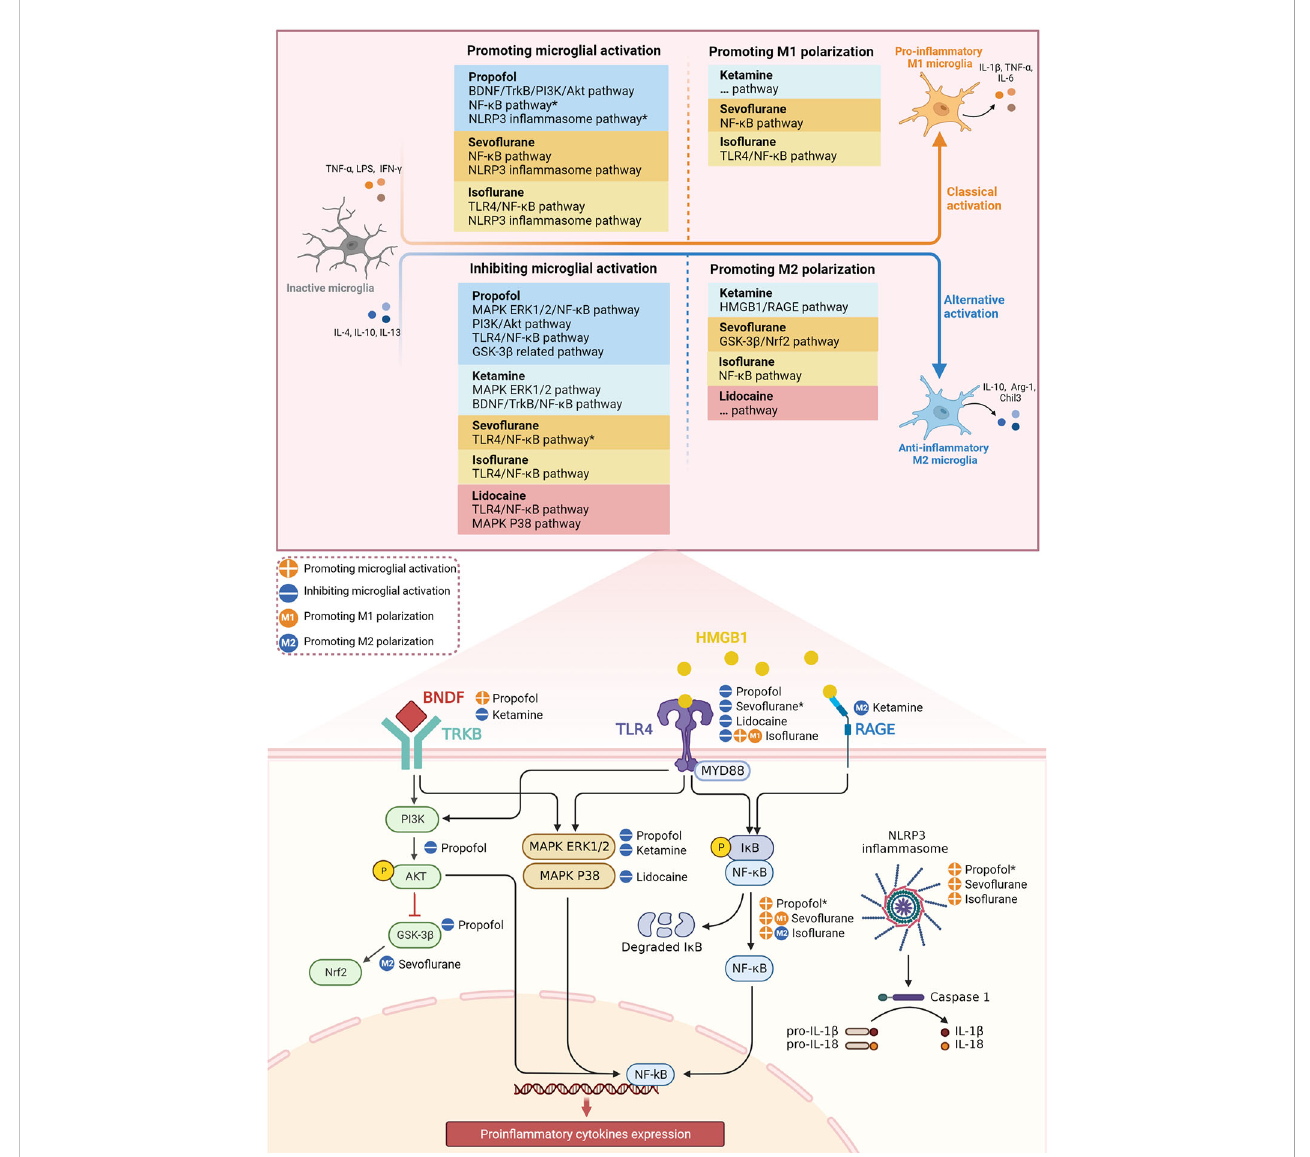
FIGURE 1 Effect of different anesthetics on microglial activation and M1/M2 polarization through in fl ammatory signaling pathways. *The potential signaling pathways involved in the mechanism of anesthetics on microglial